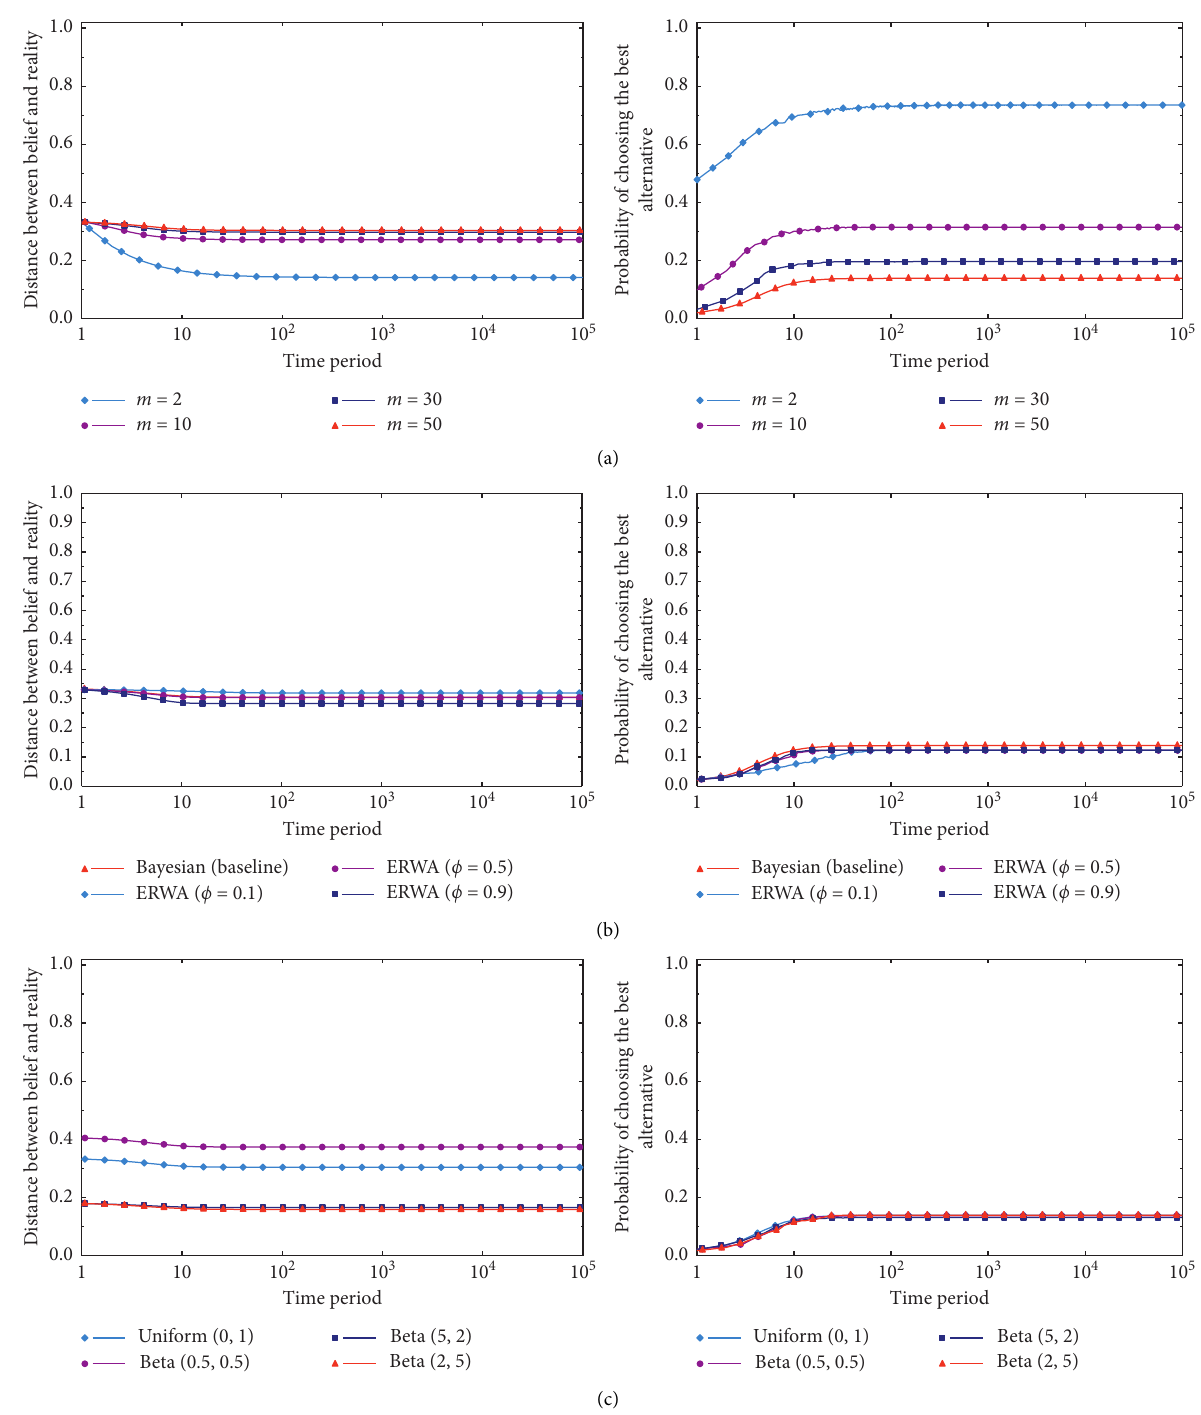
Figure 4: (a) The number of alternatives ( m ), (b) updating rules (ERWA represents exponential recency weighted average where ϕ is a degree of recency. To be specific, the agent updates its belief on the action i as follows: π i,t � ( 1 − ϕ ) π i,t −